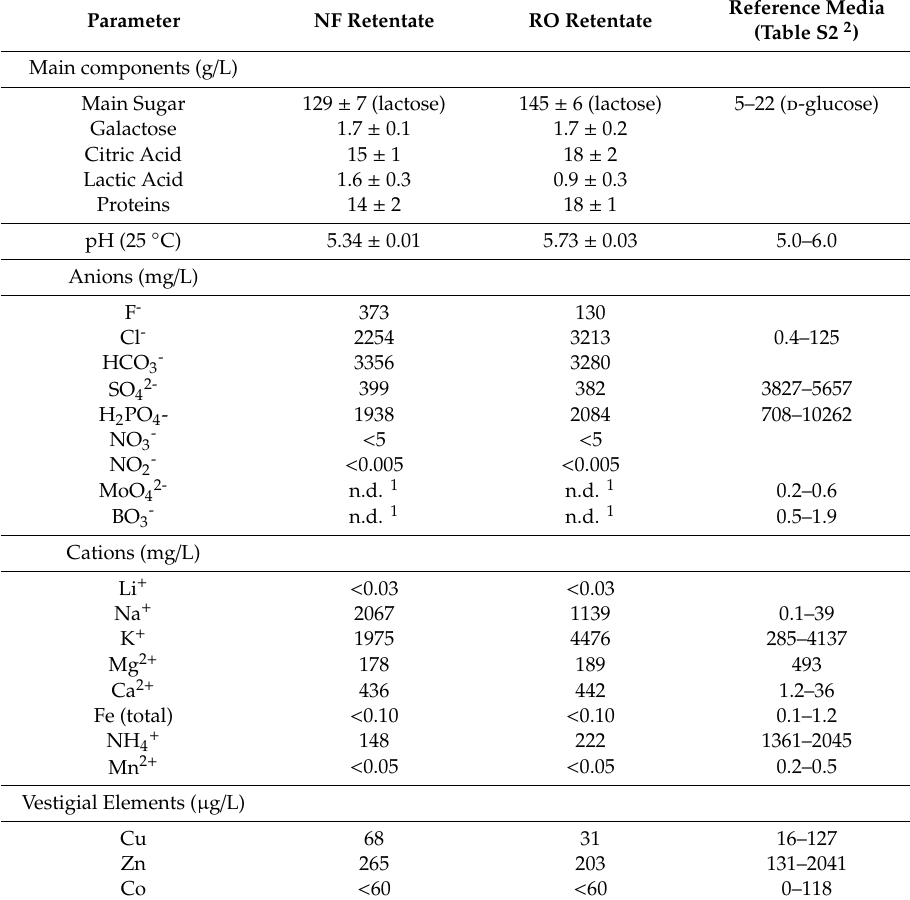
Table 3. Comparison of the processed NF and RO retentates’ properties and composition against reference defined media for yeast